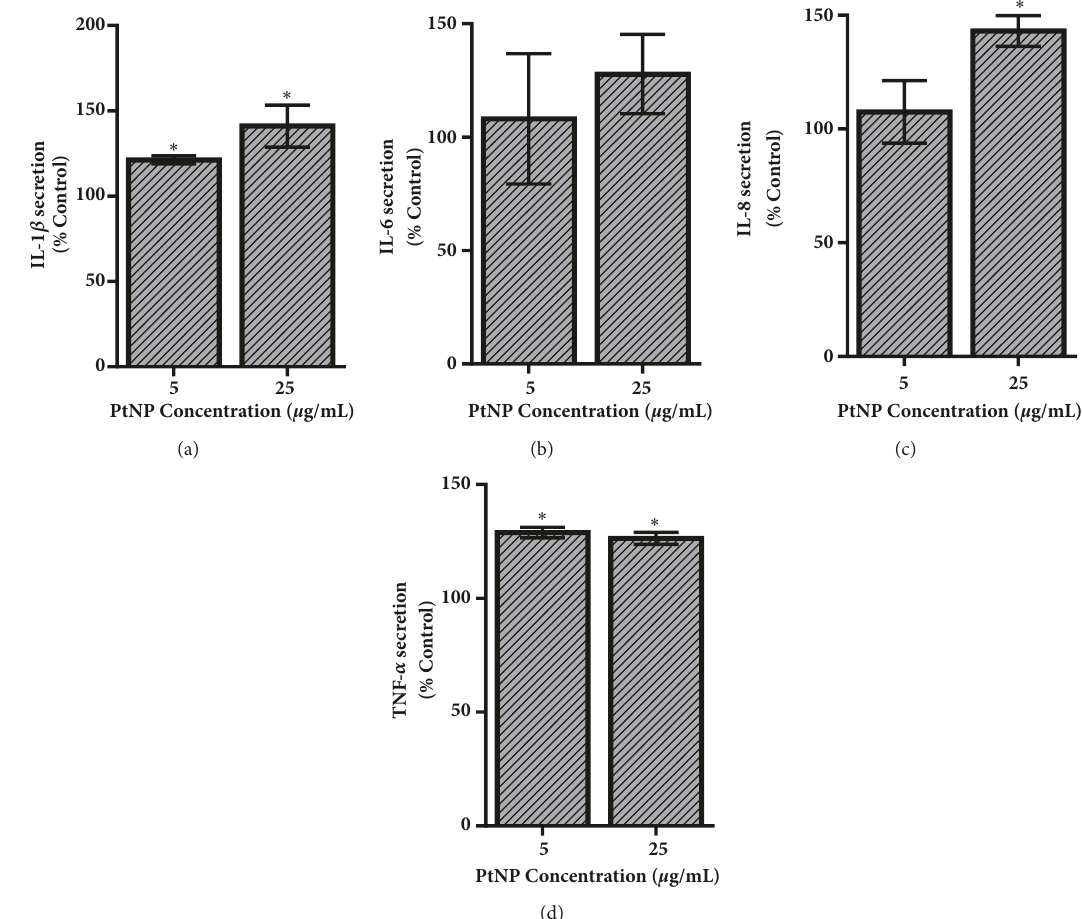
Figure 4: Activation of the HepG2 inflammatory response. To assess PtNP-dependent inflammatory activation, secretion levels of key proinflammatory cytokines were quantified. Following a 24-hour exposure to varying levels of PtNPs, the media were recovered from the HepG2 culture and underwent analysis for (a) IL-1 𝛽 , (b) IL-6, (c) IL-8, and (d) TNF- 𝛼 . Data represents 3 independent trials with ∗ denoting statistical significance from untreated controls ( p <